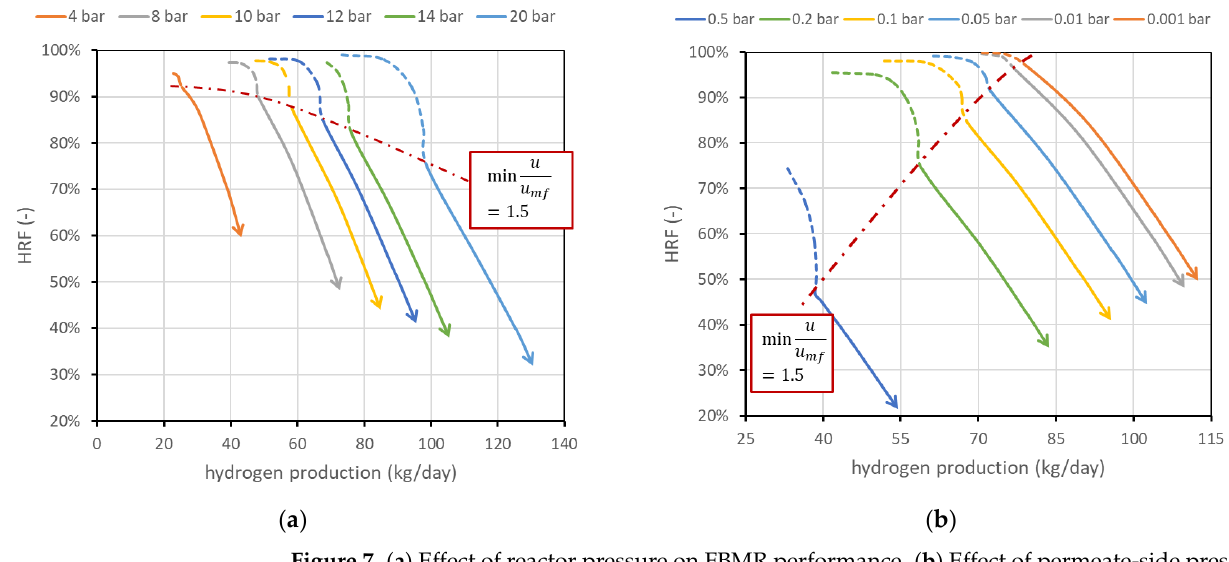
Figure 7. ( a ) Effect of reactor pressure on FBMR performance. ( b ) Effect of permeate-side pressure. Nominal values are 12 bar within the reactor and 0.1 bar in the permeate side.